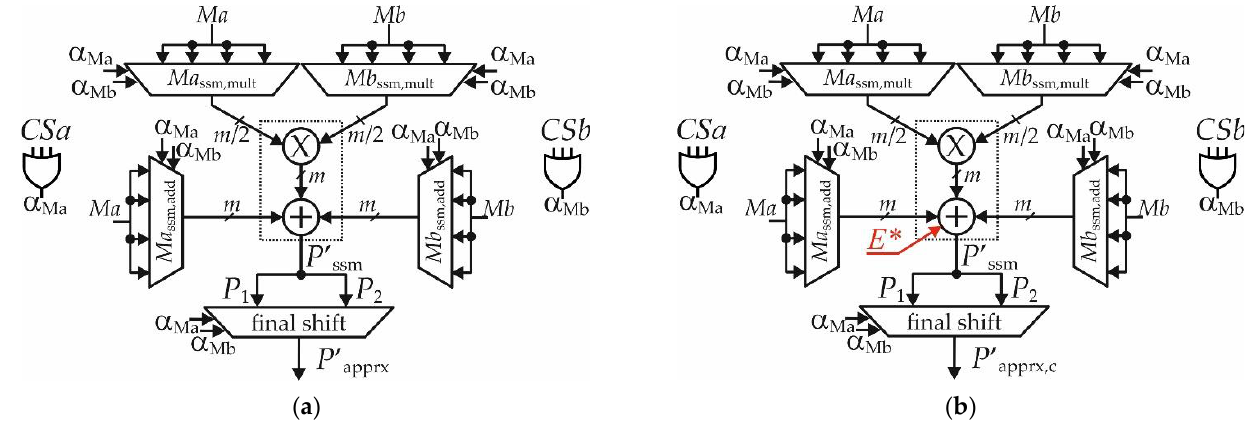
Figure 7. Block diagram of the SSMAA ( a ) without the correction term and ( b ) with the correction term (highlighted in red). Table 1. Segmentation scheme applied to Ma , Mb at the inputs of both the multiplier and the adder.